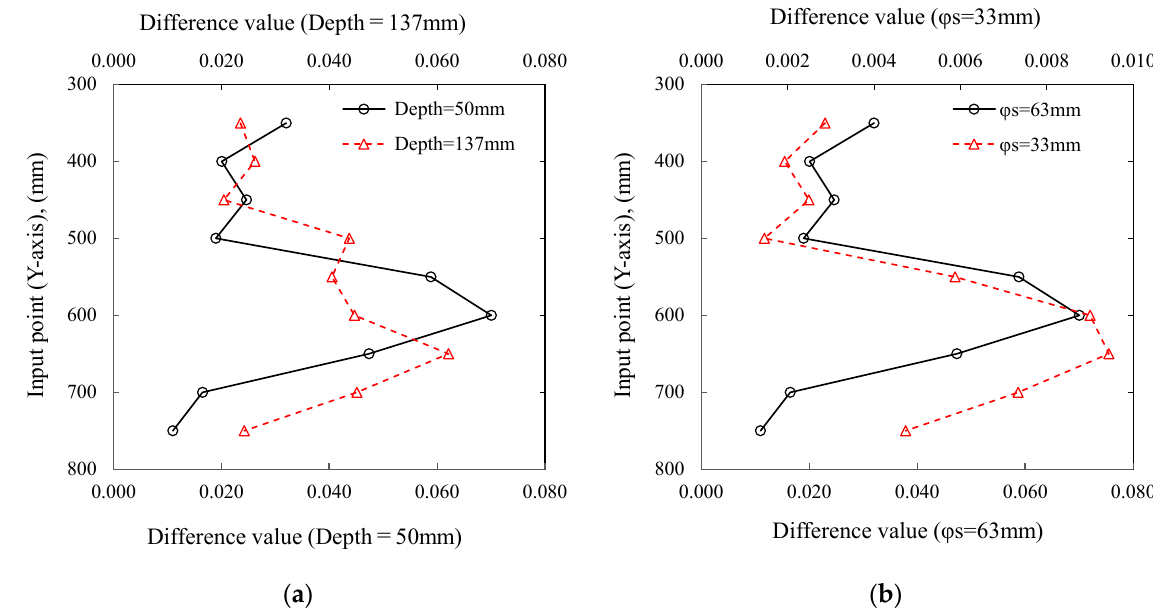
Figure 17. DVA results (X-axis of point = 800 mm): ( a ) Comparison by depth; ( b ) Comparison by sheath diameter.